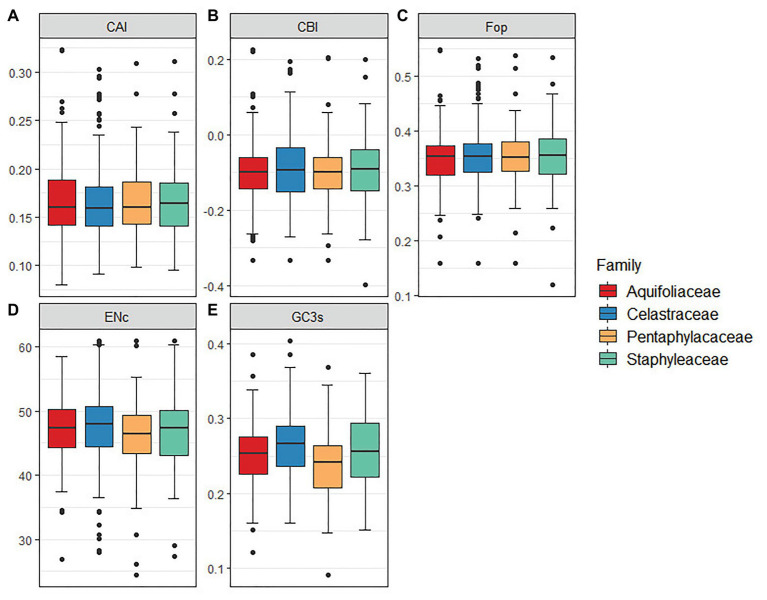
The comparative analysis of codon usage bias in 12 Celastrineae species. (A) Codon adaptation index (CAI), (B) Codon bias index (CBI), (C) Frequency of optimal codons index (Fop), (D) Effective number of codons (ENc). (E) GC of synonymous codons in third position (GC3s).